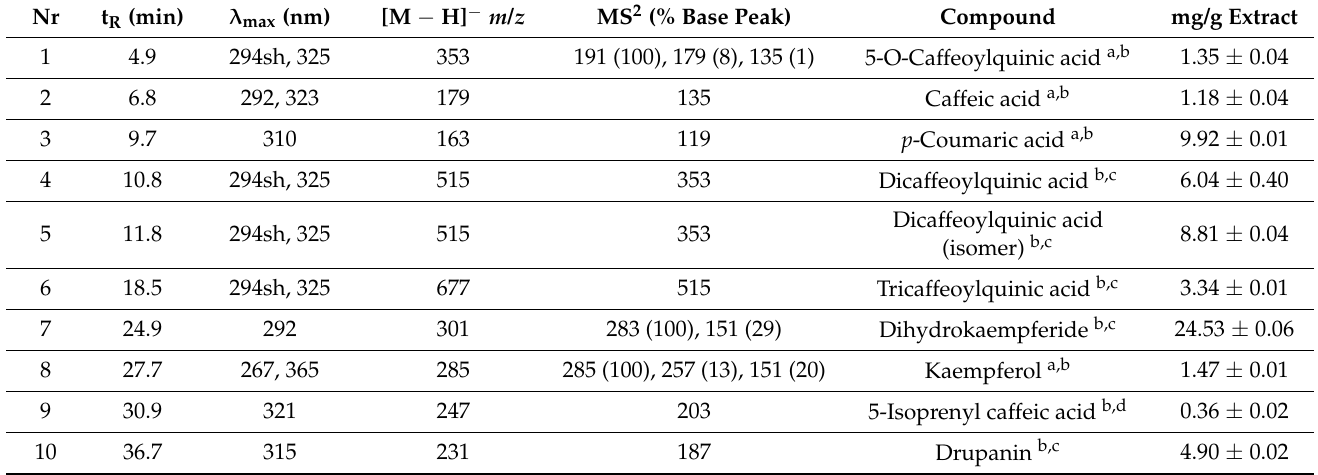
Table 1. Characterization of the phenolic compounds in green propolis extract, obtained by LC/DAD/ESI-MS n